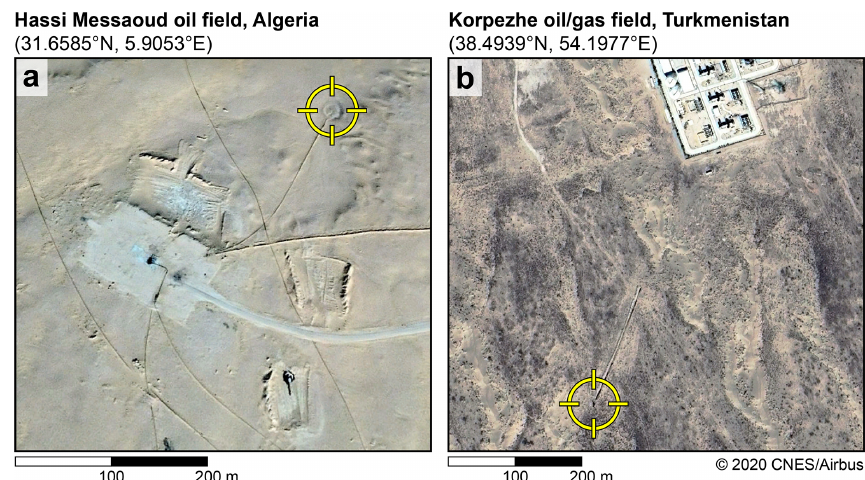
Figure 4. Surface imagery from © Google Earth showing the two oil and gas methane point sources to which our retrieval methods are applied for high-frequency Sentinel-2 monitoring. The point sources are pieces of equipment at the centers of the yellow target symbols. (a) Point source (31.6585 ◦ N, 5.9053 ◦ E) near an oil well pad in the Hassi Messaoud oil field of Algeria. The image is from 1 December 2018. (b) Point source (38.4939 ◦ N, 54.1977 ◦ E) near a compressor station in the Korpezhe oil and gas field of Turkmenistan. The image is from 24 August